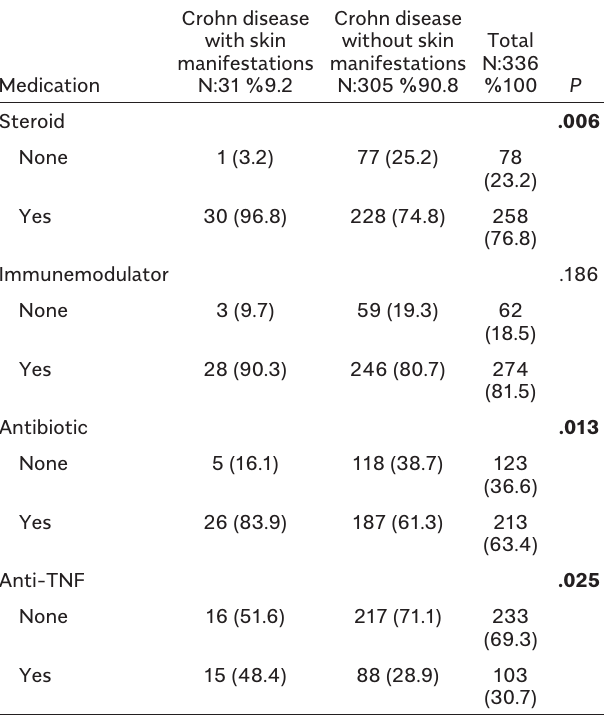
Table 2. The Relationship Between Skin Involvement and Independent Risk Factors Associated with the Medication in Crohn’s Patients Development of Mucocutaneous Involvement Multivariate Cox regression analysis showed that female Crohn disease Crohn disease gender (HR: 3.28, 95% CI: 1.51-7.14, P = .003) and cortico- with skin without skin steroid use (HR: 7.88, 95% CI: 1.07-57.97, P = .043) were manifestations manifestations Medication N:31 %9.2 N:305 %90.8 found to be independent risk factors for the development of skin findings. Family history (HR: 3.59, 95% CI: 2.18- 5.93, P < .001) and presence of inflammatory disease (HR: